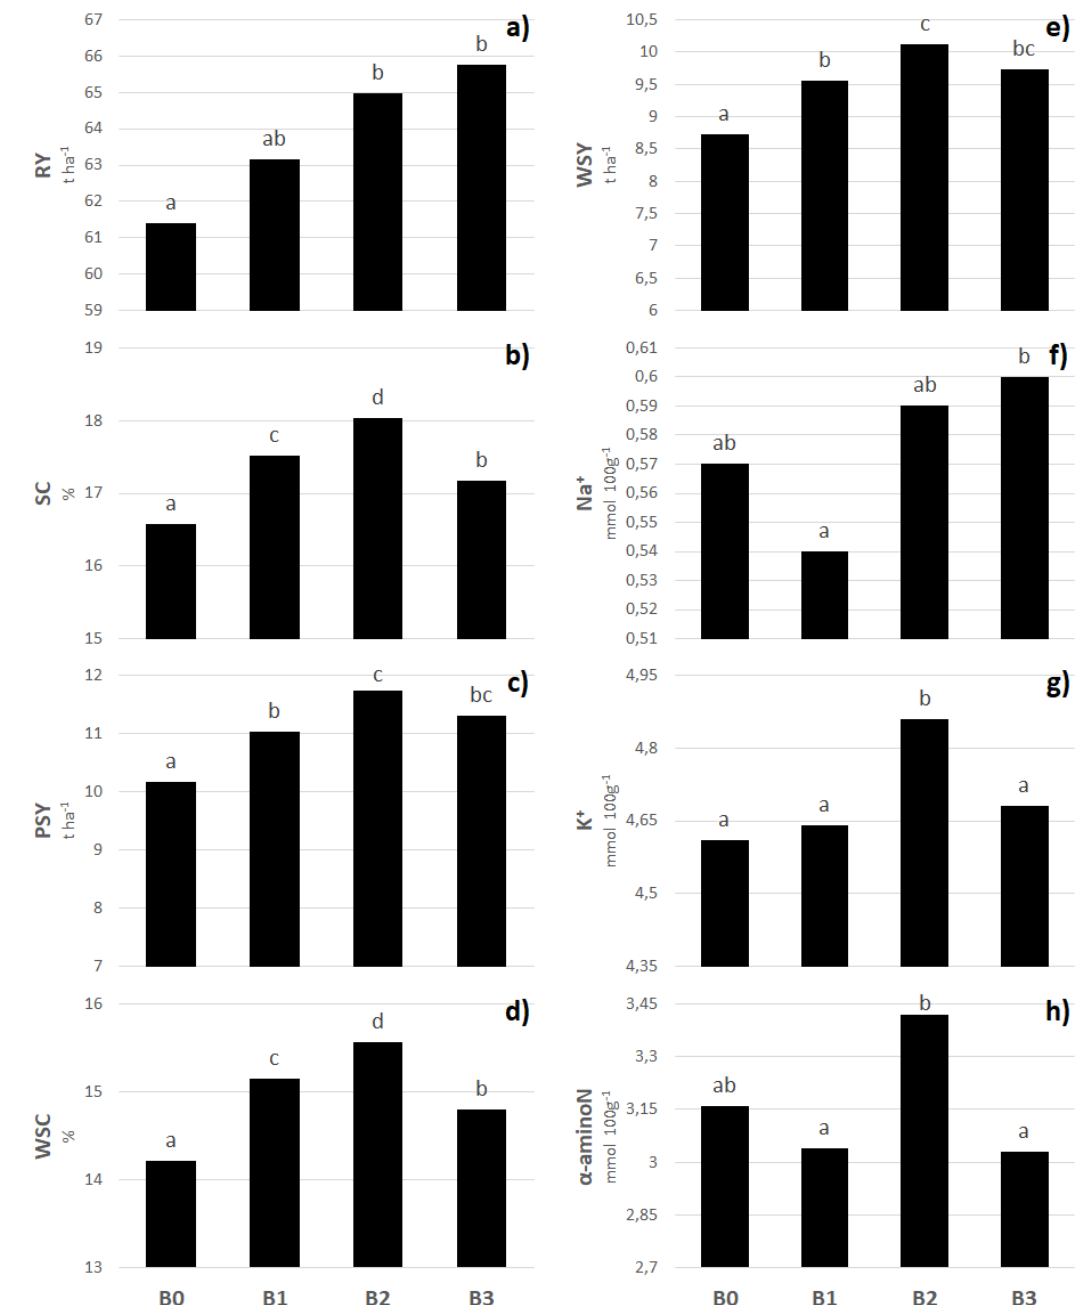
Figure 1. Different sources of biostimulants influence on production traits of sugar beet. (RY repre- sented root yield ( a ); SC–sugar content ( b ); PSY–polarized sugar yield ( c ); WSC–white sugar content ( d ); WSY–white sugar yield ( e ); Na + –sodium content ( f ); K + –potassium content ( g ); α-aminoN–α- aminonitrogen content ( h ); B0–control; B1–humic acids, essential amino acids; B2–essential amino acids biopolymers, soil bacteria; B3–humic acids, essential amino acids biopolymers, soil bacteria). The figure was obtained at a level of significance α = 0.05.